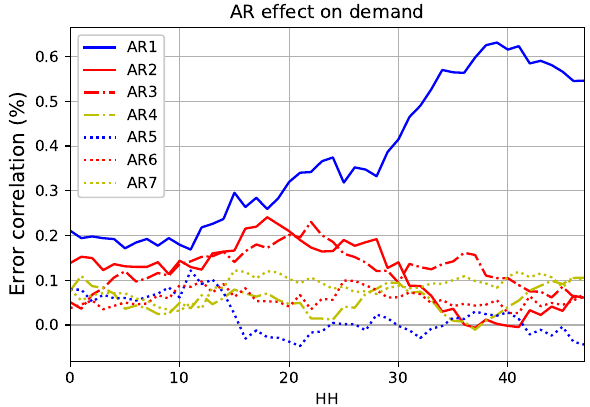
Figure 4. Measure of correlated error for individual